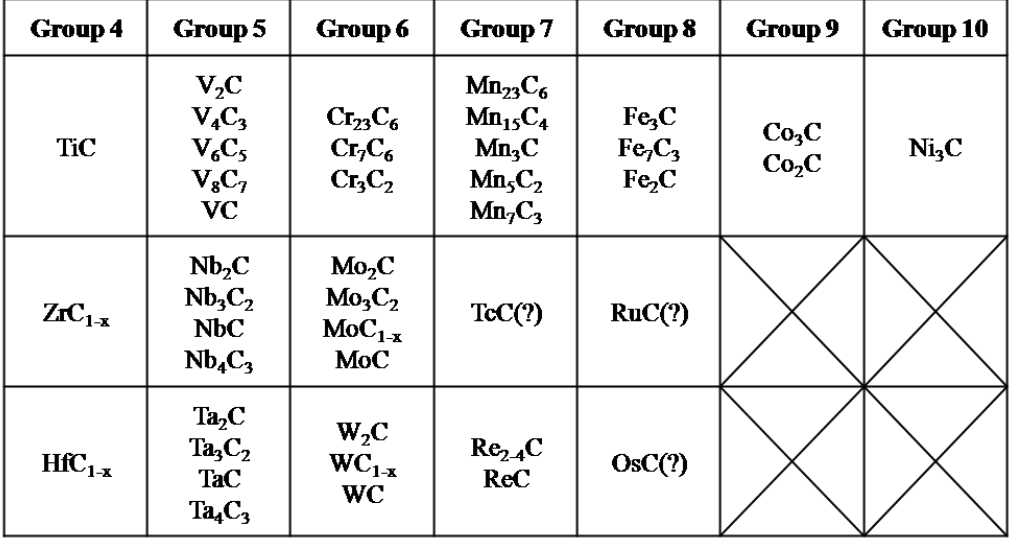
Table 1. Transition metal carbides and their positions in the periodic